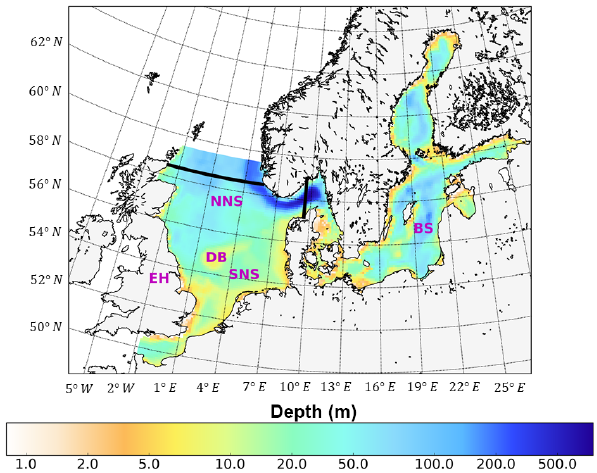
Figure 1. Bathymetry and simulation domain of ECOSMO. Black lines indicate the area of the North Sea used for analysis, from 5 ◦ W to 9.5 ◦ E in the east–west direction and from 48 to 58.5 ◦ N in the south–north direction. SNS and NNS are short for the southern and northern North Sea, respectively. BS is short for the Baltic Sea. DB and EH are short for Dogger Bank and the Estuary of Humber, re-